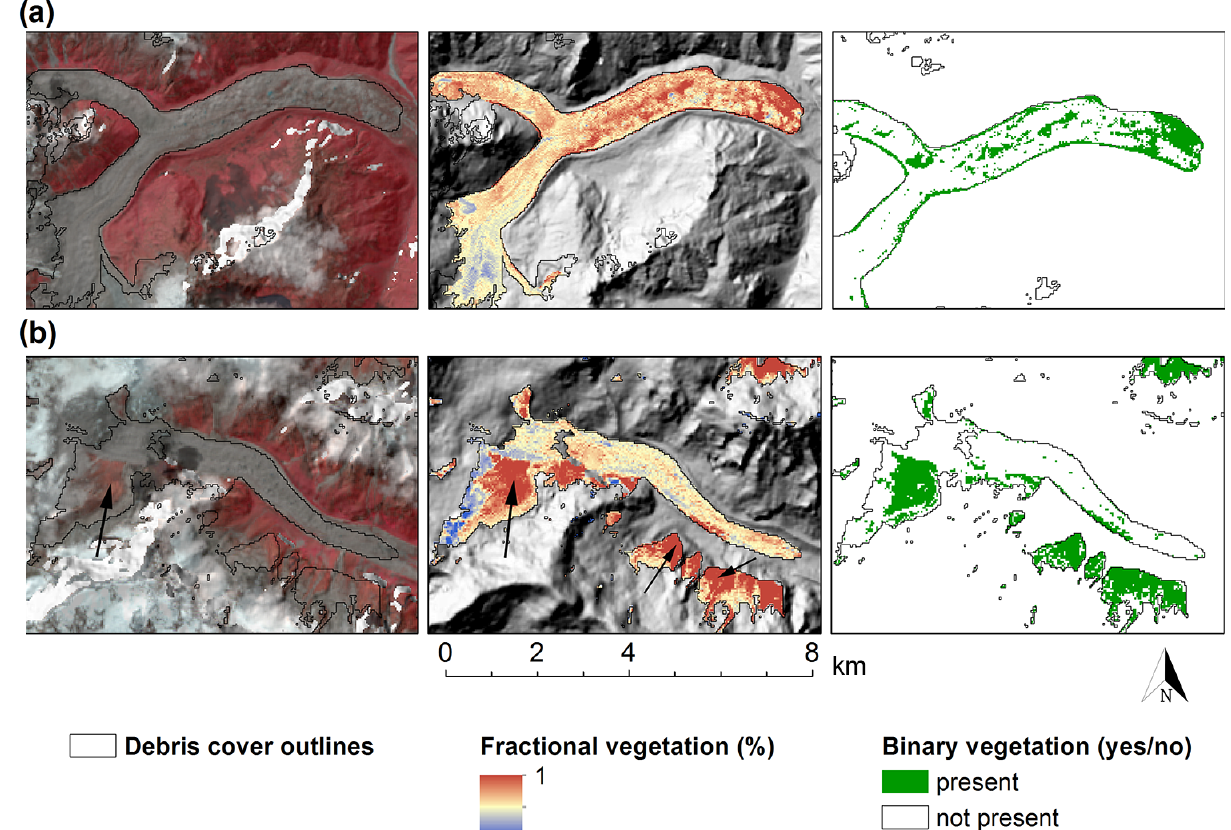
Figure 10. Examples of the supraglacial vegetation maps for two glaciers in the eastern Himalaya: (a) Kazhenpu Glacier; (b) Labeilang Glacier. Left panels show the Landsat 8 OLI colour composite (bands 5, 4, 3) draped onto a shaded relief map from the ALOS DEM. Middle panels show fractional vegetation, and black arrows point to identified errors (bare land and/or healthy vegetation) in the SDC dataset. Right panels show the pixels containing more than 65% fractional vegetation.